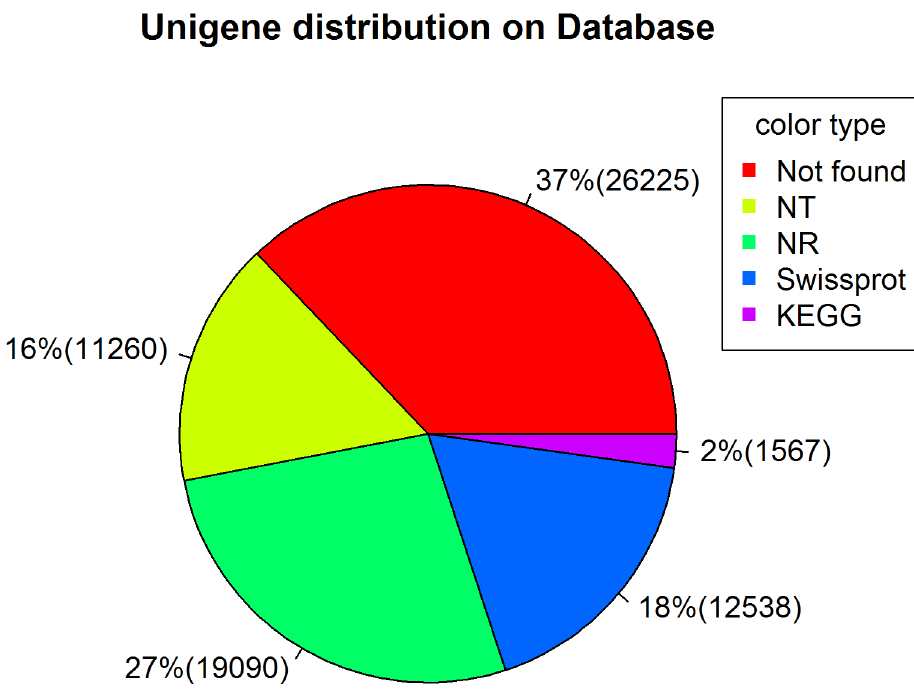
Fig 1. A pie chart showing proportions (with numbers in parentheses) of transcripts annotated by NR, Swiss-prot, NT and KEGG databases.